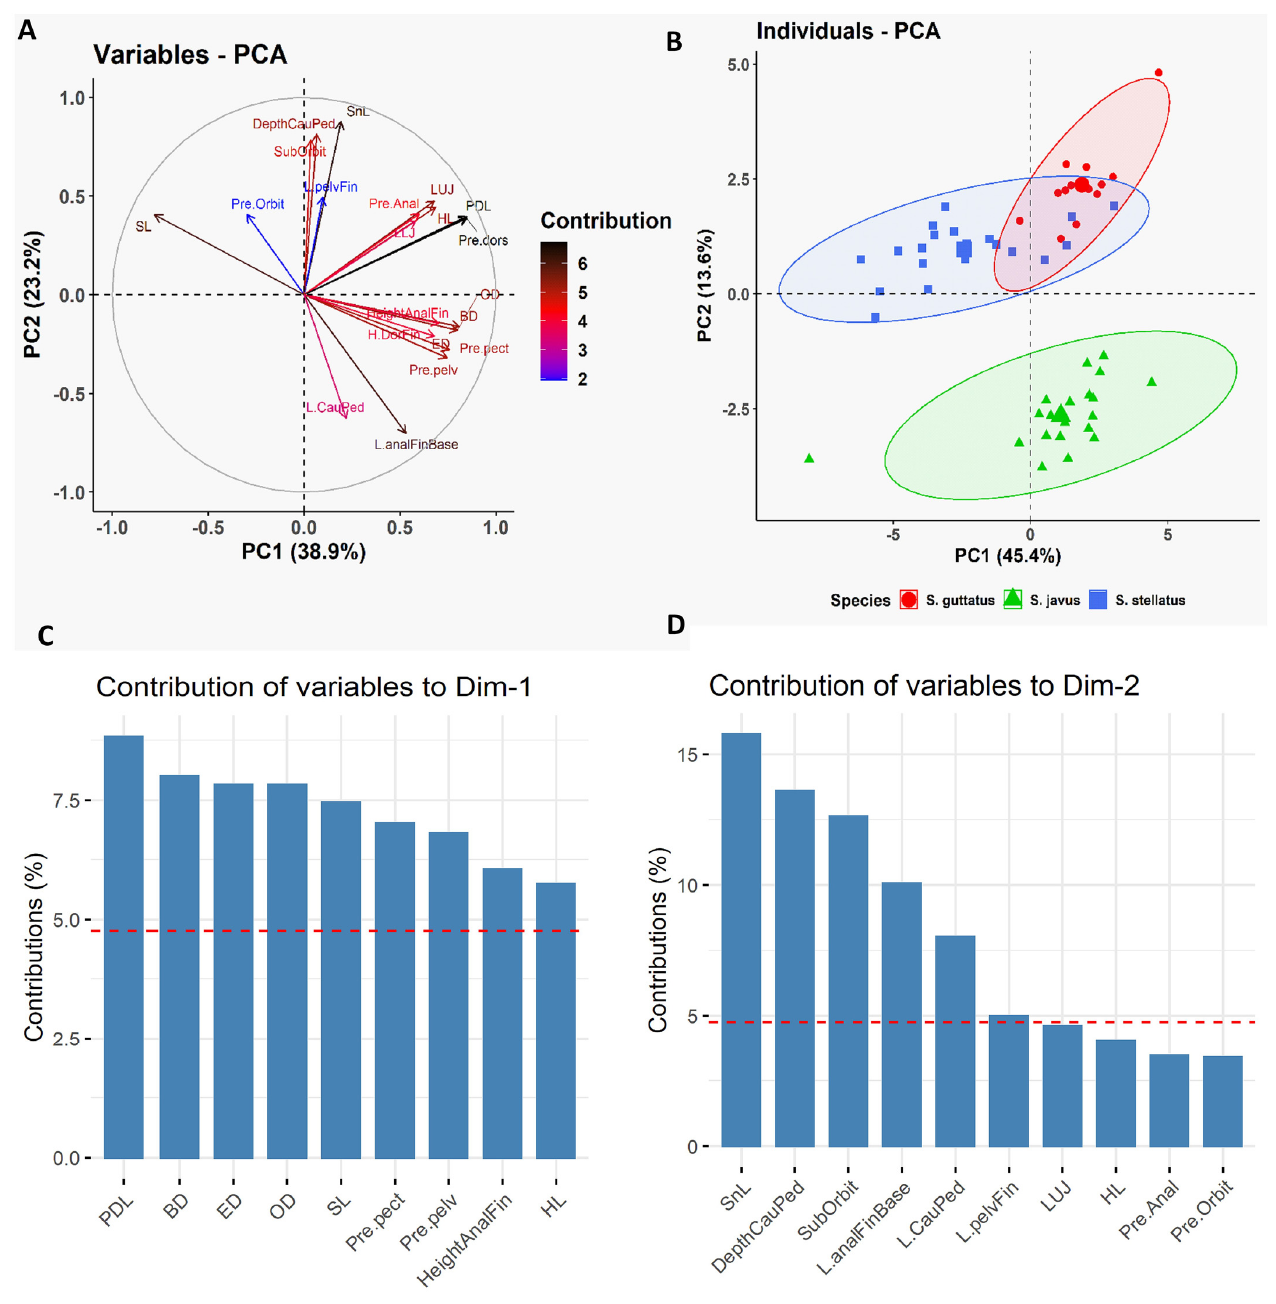
Figure 3. Principal Component Analysis (PCA) of morphometric data of three deep-bodied siganid species [ S. guttatus ( n = 14), S. javus ( n = 20) and S. stellatus ( n = 20)] collected from the South China Sea, Terengganu, Malaysia. ( A ) Biplot of the variable PCA is shown based on the morphometric data of three deep-bodied siganid species. ( B ) Biplot of the individual PCA is shown based on the morphometric data of three deep-bodied siganid species. ( C ) Relative contribution of morphometric variables to Dim-1 to discriminate three deep-bodied siganid species. ( D ) Relative contribution of morphometric variables to Dim-2 to discriminate three deep-bodied siganid species.